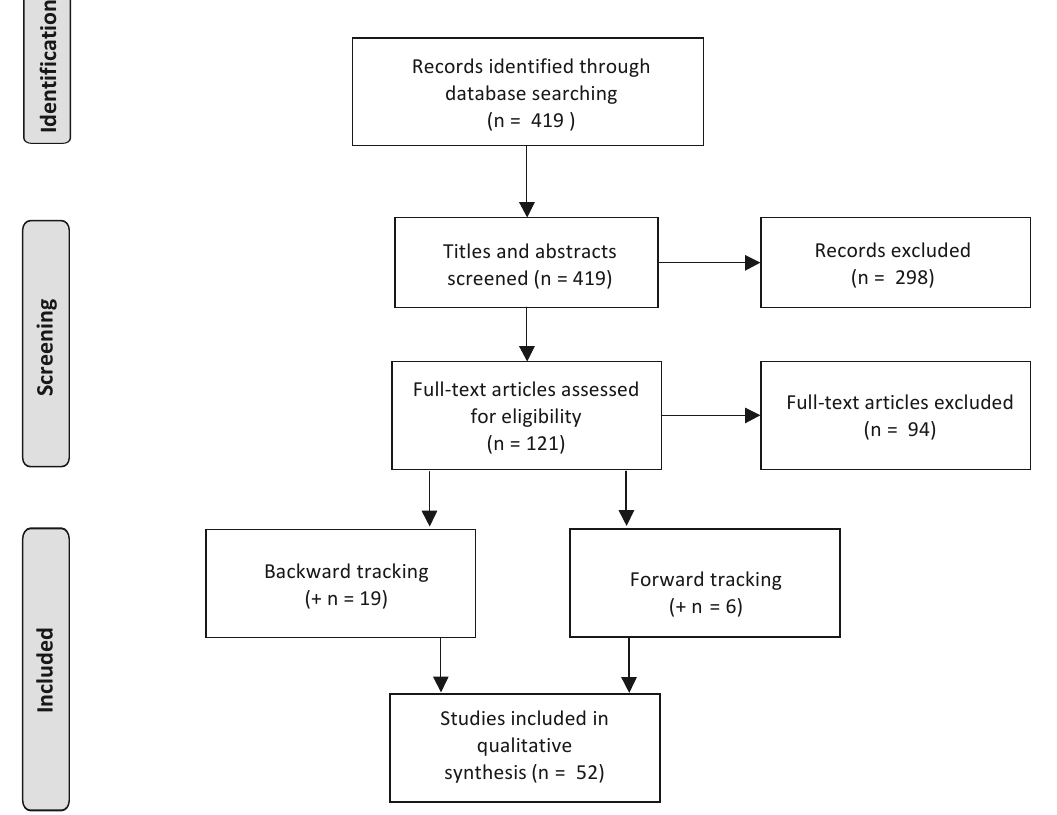
Figure 1. PRISMA review protocol based on Moher et al.